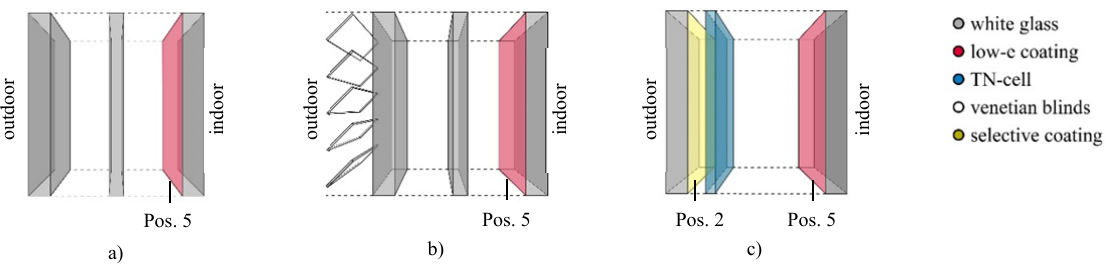
Fig. 6 Simulated glazing systems: a) glazing A, b) glazing B, c) glazing C. Drawings: D. Meurer, M. Husser,